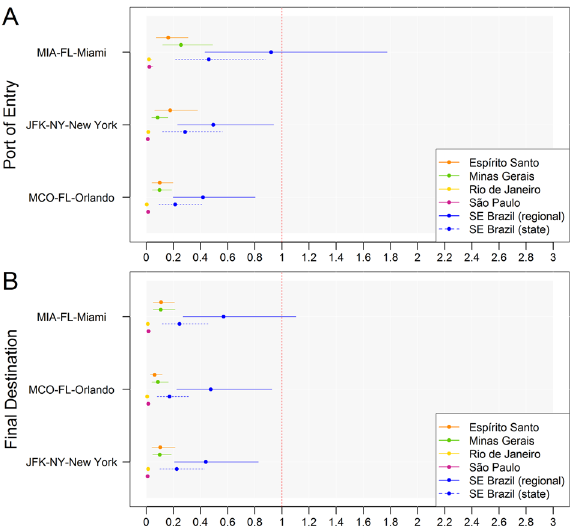
Figure 1. Baseline risk of YFV importation into the United States in 2016–2017. Mean and 95% confidence AW interval of the estimated total number of YFV importations ( I , comprising incoming Brazilian travelers, S , S returning US travelers and international travelers) entering the United States at the specified ports of entry ( A ) and final destination airports ( B ) during the 2016–2017 YF outbreak. Only US airports with an upper 95% confidence limit exceeding 0.5 over all Brazilian states in Southeast Brazil (regional estimate) are shown. These estimates were obtained assuming 70% vaccination coverage of US and international travelers to Brazil. Uncertainty derives from sampling 10,000 stochastic realizations of the length of stay, incubation period, infectious period, number of asymptomatic or mild infections for each severe YFV case and vaccine efficacy from their respective distributions. SE Brazil = Southeast